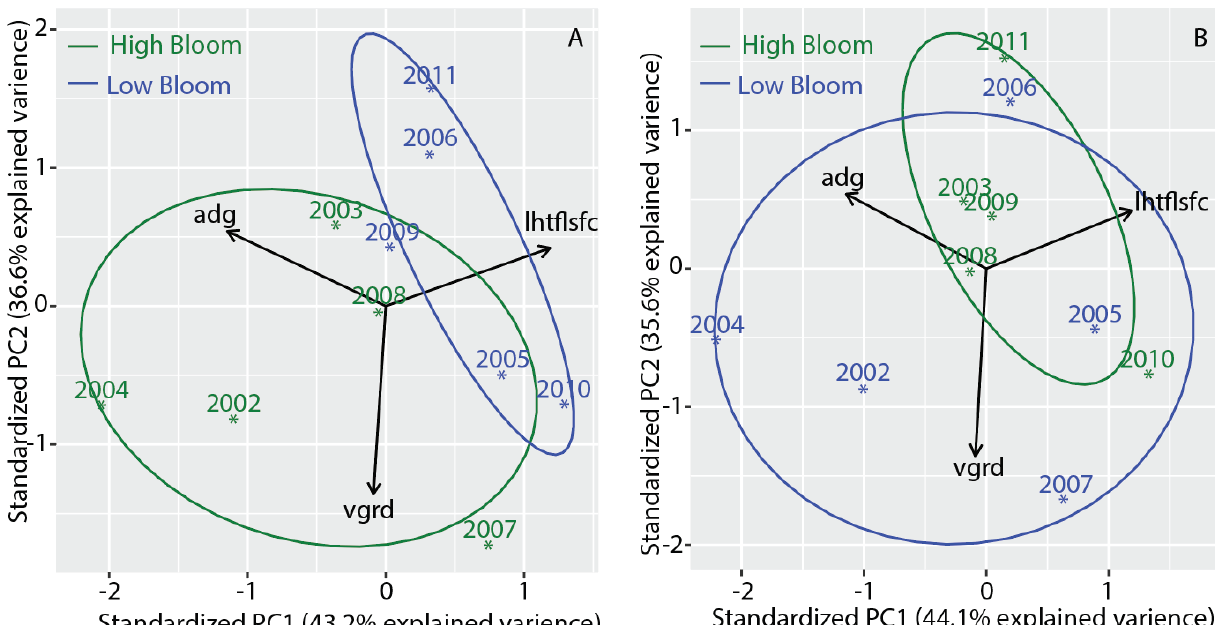
Figure 9. Principal Components Analysis (PCA) by year (2002 – 2011) for the separation between the top five high and bottom five low bloom years for 2003 – 2011 using best models for Green Bay. Three-parameter PCA for Green Bay ( A ) and western Lake Erie ( B ) showing the separation between high (green) and low (blue) bloom years. The three input parameters were gelbstoff absorption (adg), the meridional wind speed (vgrd), and latent heat flux (lhtflsfc) as having been identified as drivers for blooms in Green Bay.